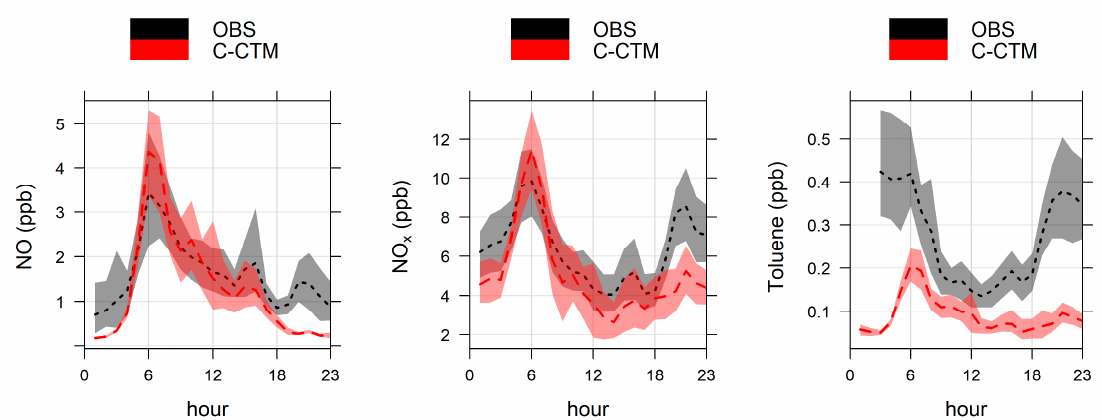
Figure 10. Average daily variations of mean mole fractions of NO, NO x and toluene during the campaign with all data with a ratio of NO to CO ≥ 0.06 excluded (to remove the katabatic flow events). Observations are shown in black and simulations using C-CTM are shown in red, with the dotted central lines representing the mean and the shaded area the 95% confidence interval.